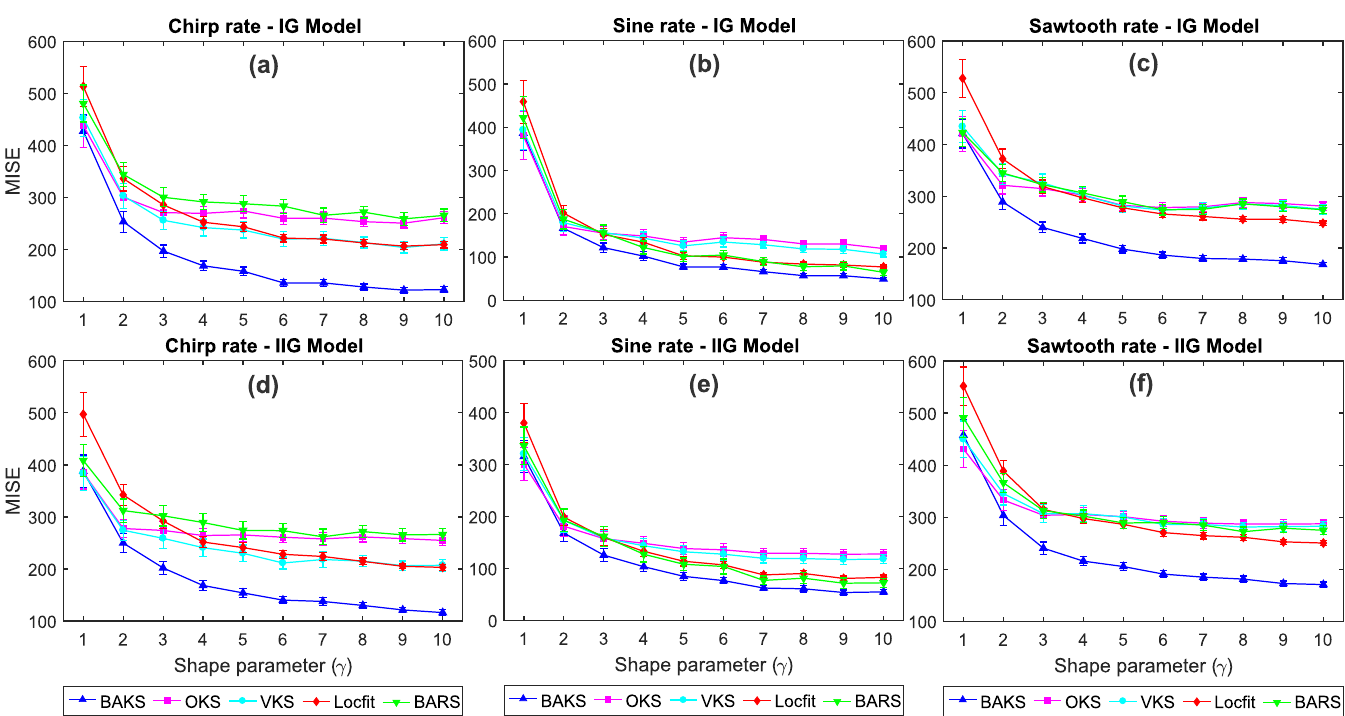
Fig 7. MISE comparison under various values of shape parameter ( γ ). (a)-(c) MISE comparison for chirp, sine, and sawtooth rate functions, respectively, from IG model. (d)-(f) MISE comparison for chirp, sine, and sawtooth rate functions, respectively, from IIG model. Vertical bars represent the 95% confidence intervals.